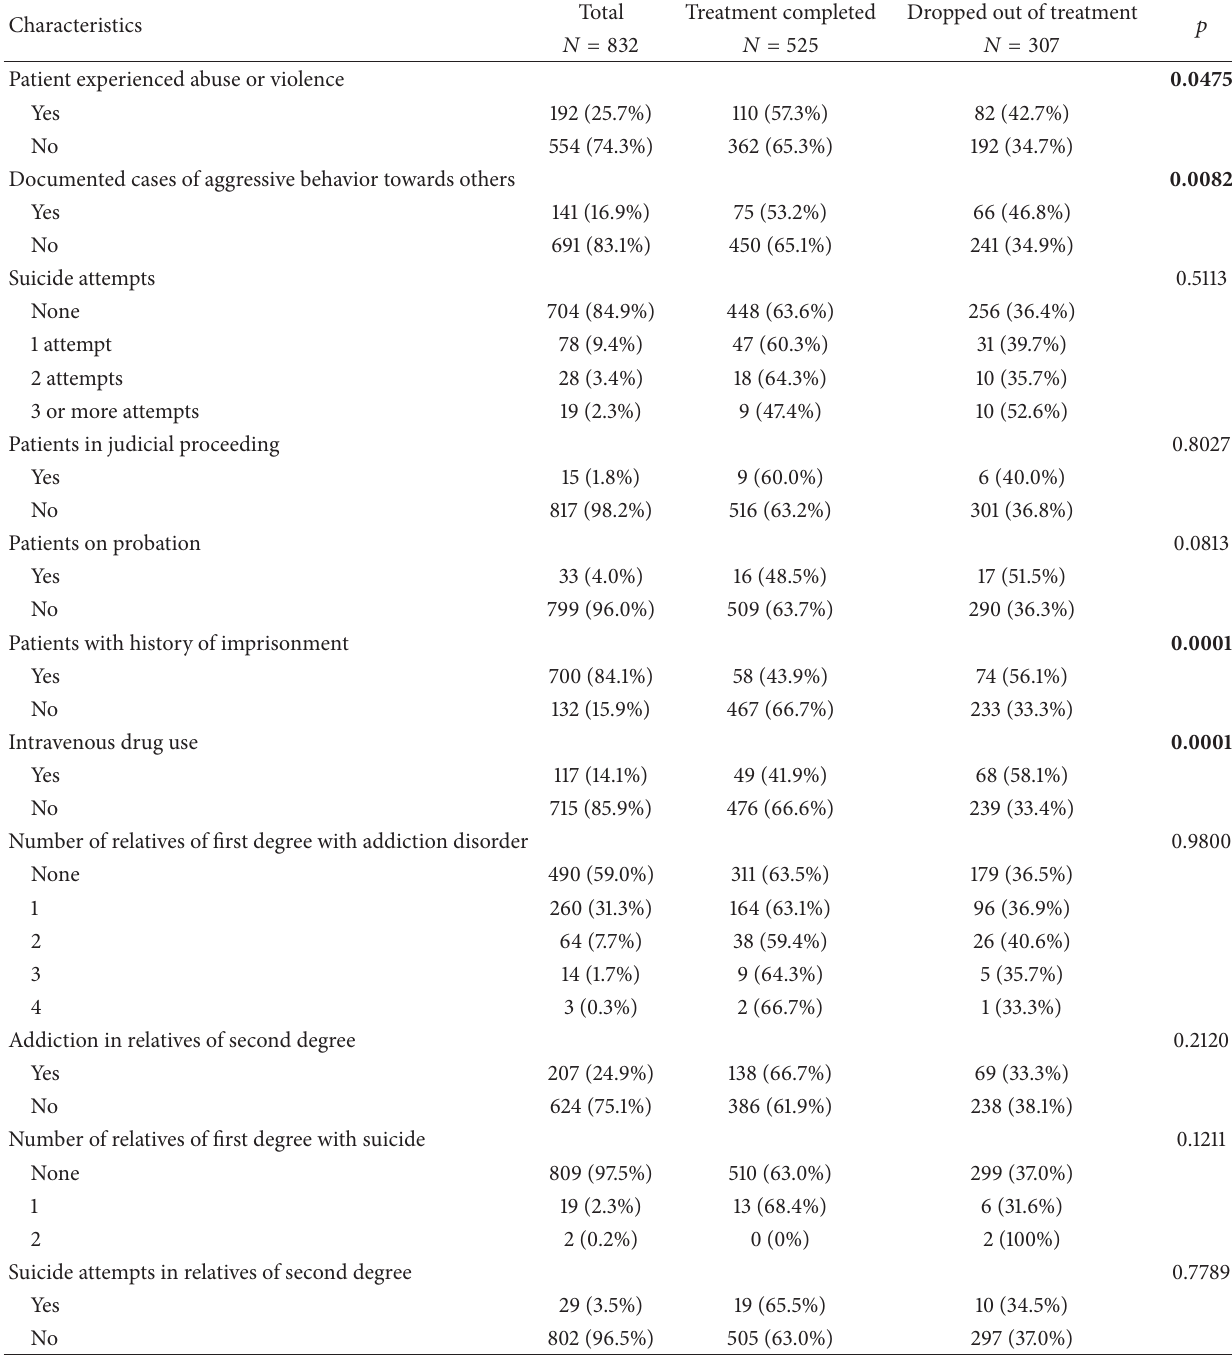
(a) Results of likelihood Chi square test for impulsiveness related variables associated determinants of premature treatment drop-out. Characteristics